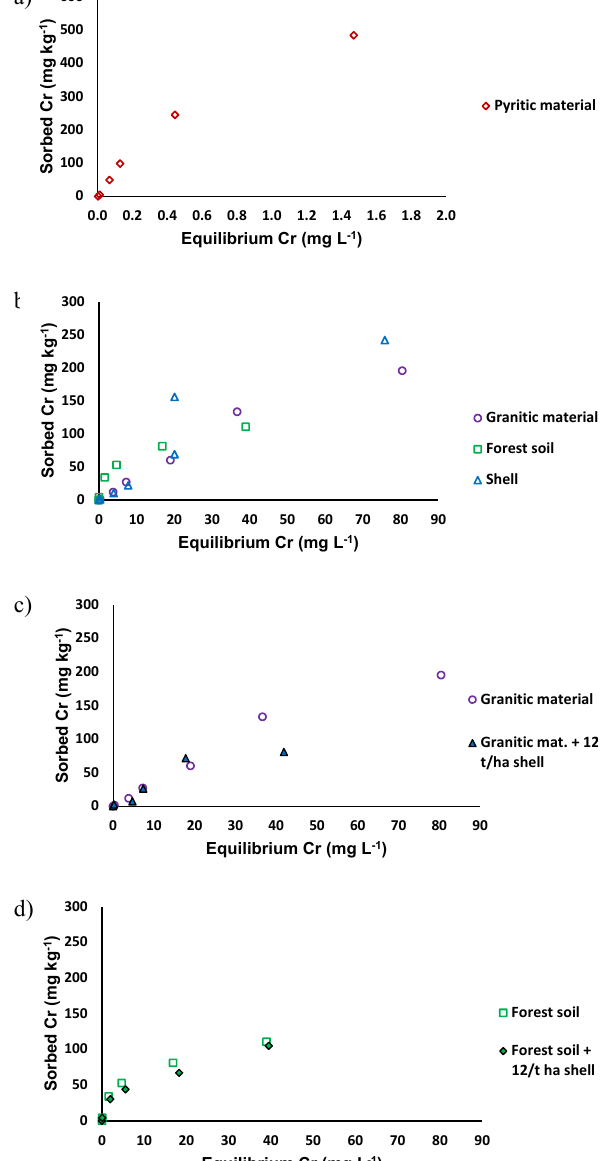
Table 3. Fitting of the various materials to the Freundlich